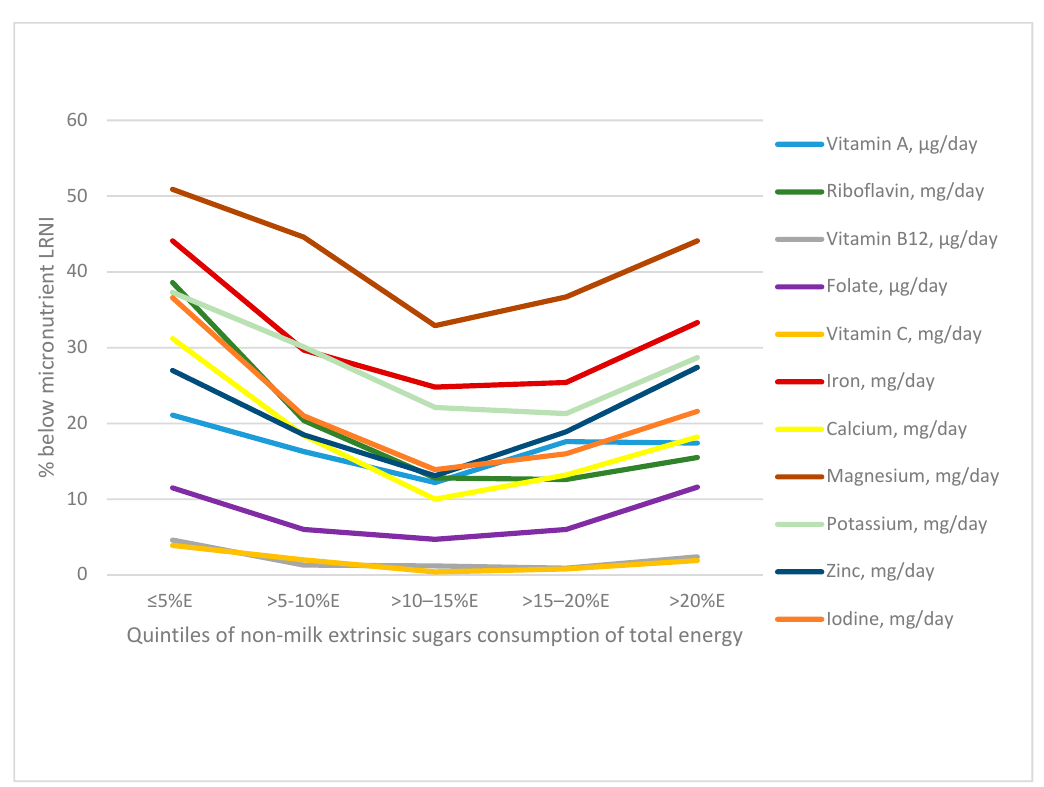
Figure 4. Percentage of adolescents aged 11 to 18 years in the National Diet and Nutrition Survey with micronutrient intakes below LRNI by percentage of non-milk extrinsic sugars consumption of total energy ( n = 2587) after the application of survey weights.